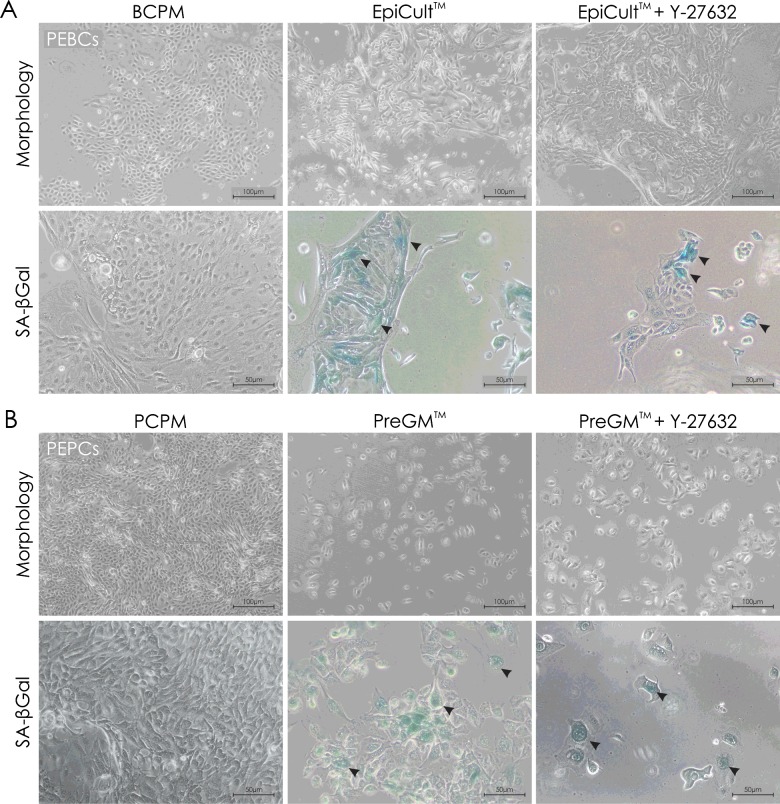
Primary epithelial cancer cells cultured in different media(A) Corresponding passages of PEBCs cultured in BCPM, EpiCult™ or EpiCult™ supplemented with ROCK inhibitor (Y-27632) with additional analysis of SA-β-gal activity (blue; arrows mark exemplary SA-β-gal-positive cells). (B) Corresponding passages of PEPCs cultured in PCPM, PrEGM™ or PrEGM™ supplemented with ROCK inhibitor (Y-27632), with additional analysis of SA-β-gal activity (blue; arrows mark exemplary SA-β-gal-positive cells).